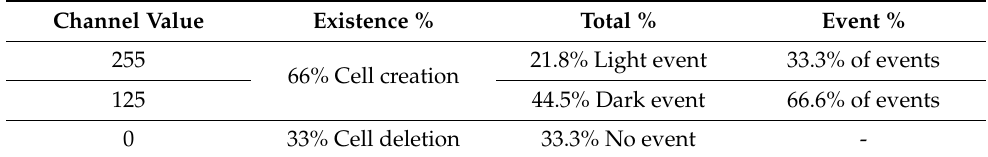
Table 3. Possible events and their probability. Notice that the third channel value is 125 (below 127.5). Each channel position is combined in a three part color